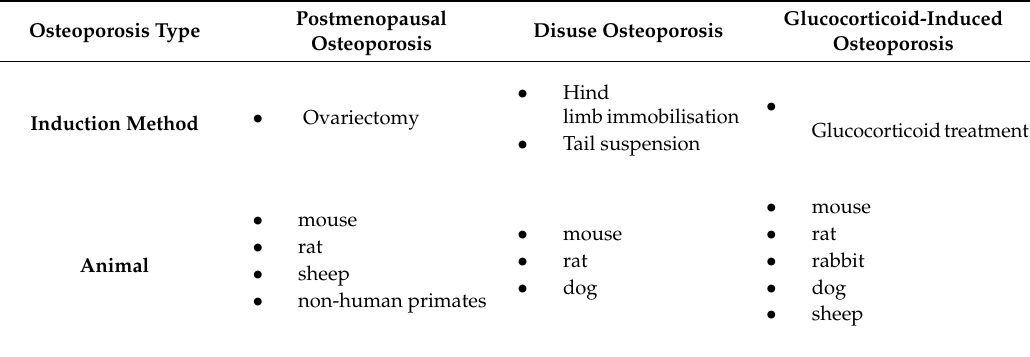
Table 1. Overview of the major available osteoporosis animal